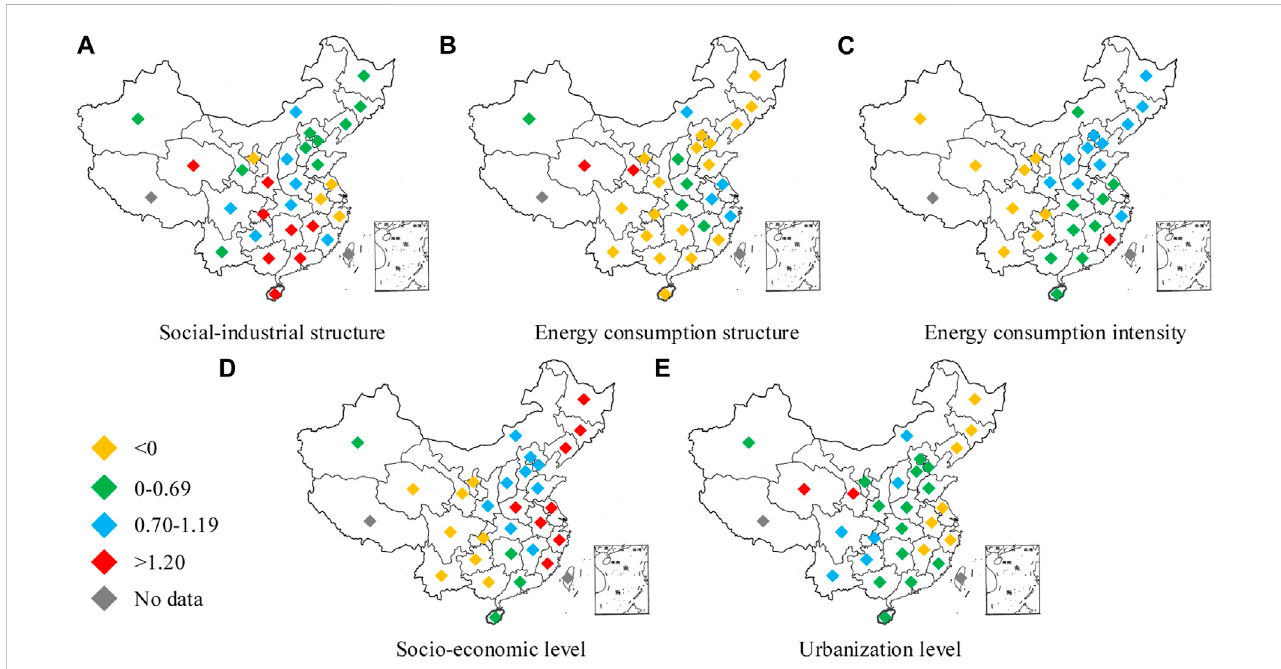
FIGURE 7 Inter-provincial differences of in fl uence factors on carbon emissions. (A) Social-industrial structure. (B) Energy consumption structure. (C) Energy consumption intensity. (D) Socio-economic level. (E) Urbanization